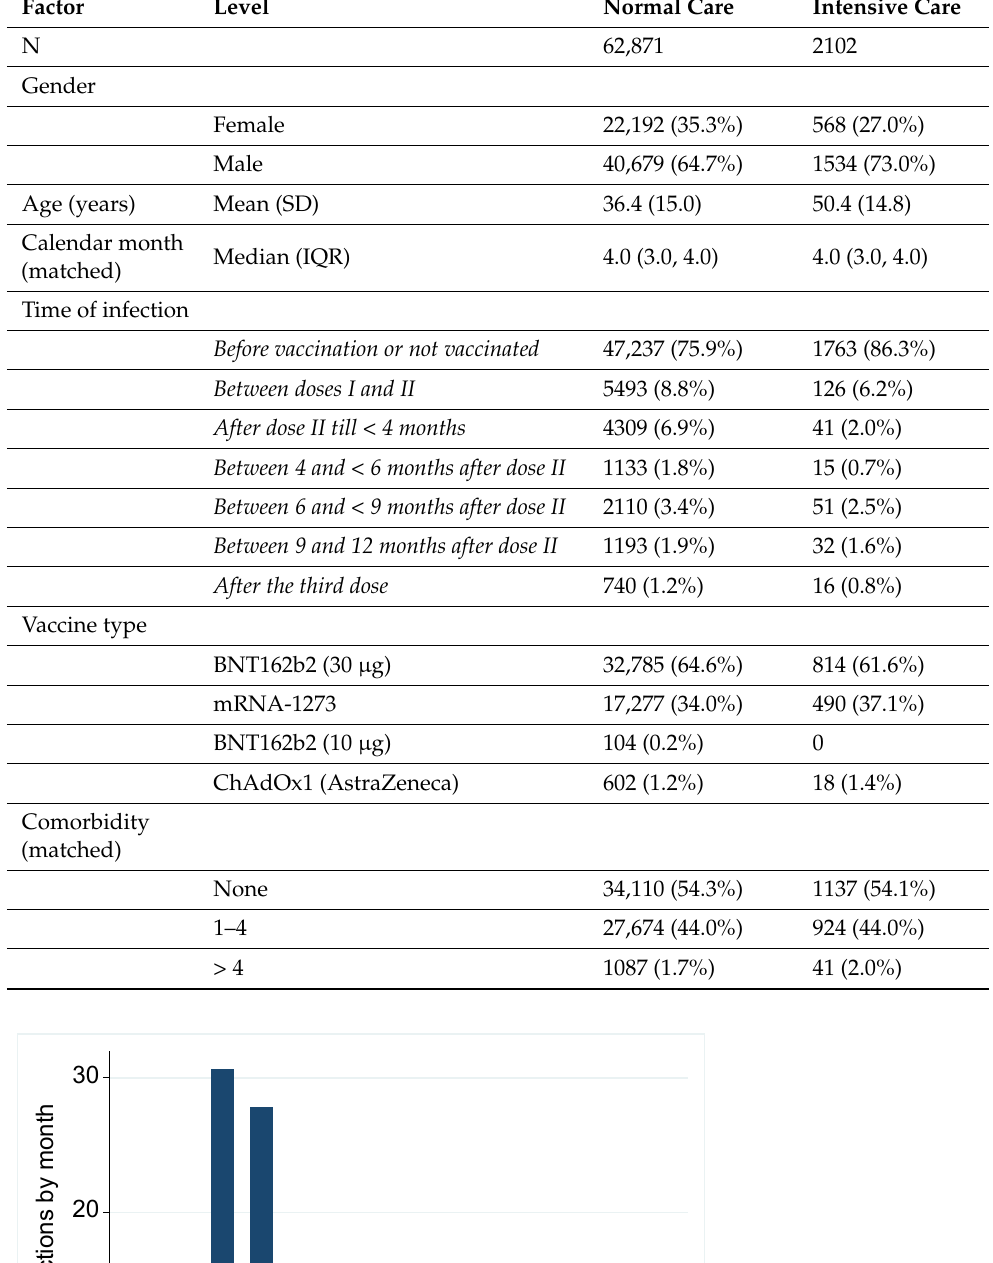
Table 1. Baseline characteristics of the participants included in the matched case control study.